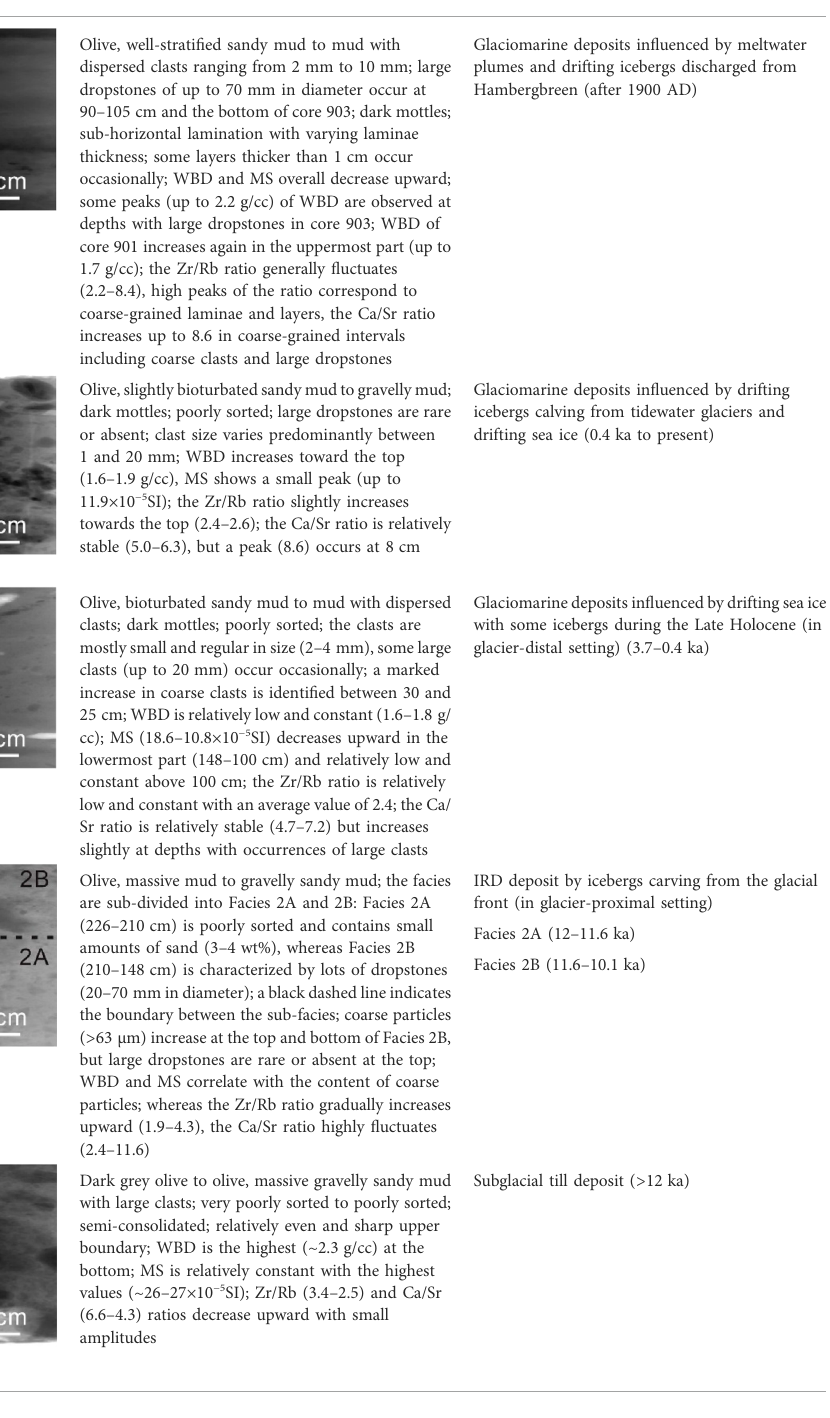
TABLE 3 Lithofacies de fi ned in the studied sediment cores. The darker intervals in X-radiographs re fl ect denser materials. See Figures 6, 7 for the stratigraphic distribution of lithofacies. Sedimentary